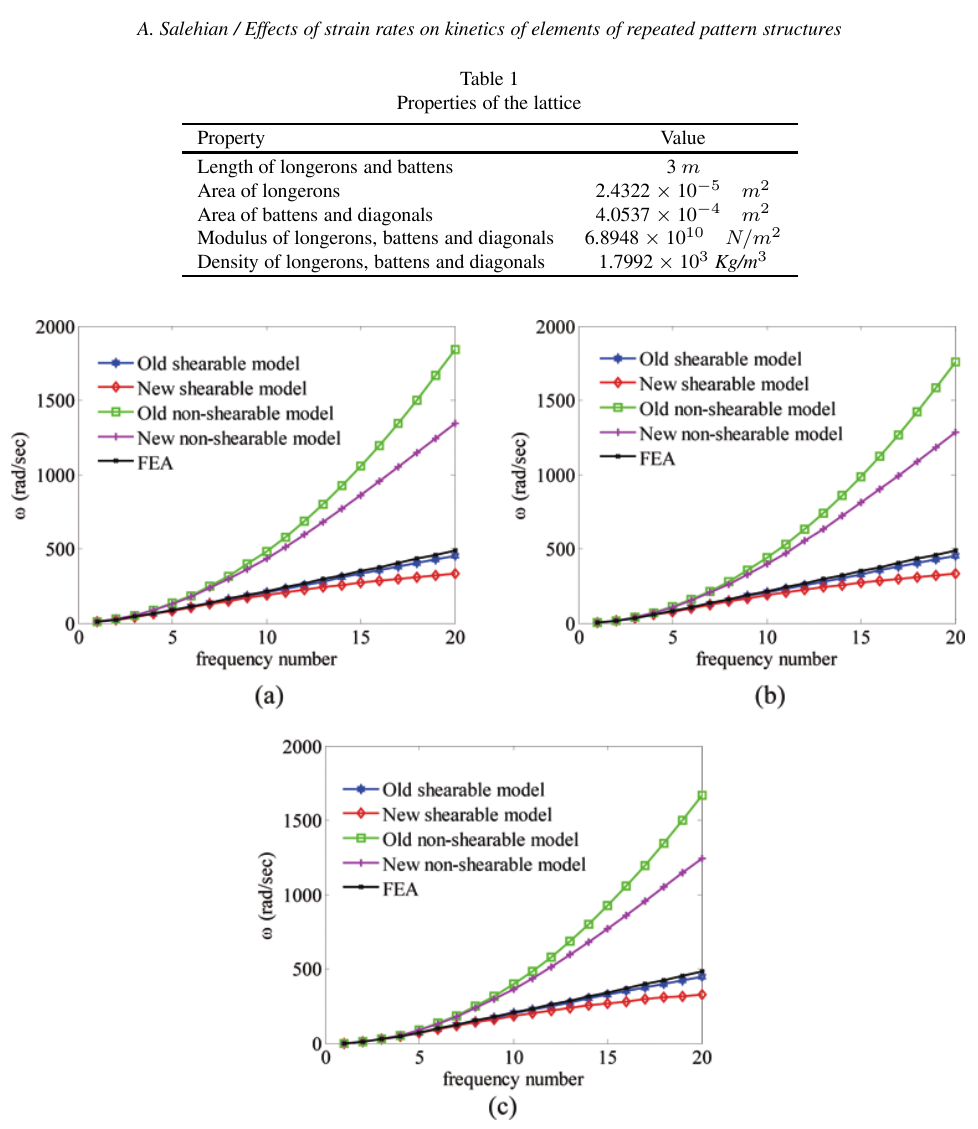
Fig. 2. Bending natural frequencies for a 120 m lattice structure for a) clamped-clamped; b) simply supported; c) free-free boundary